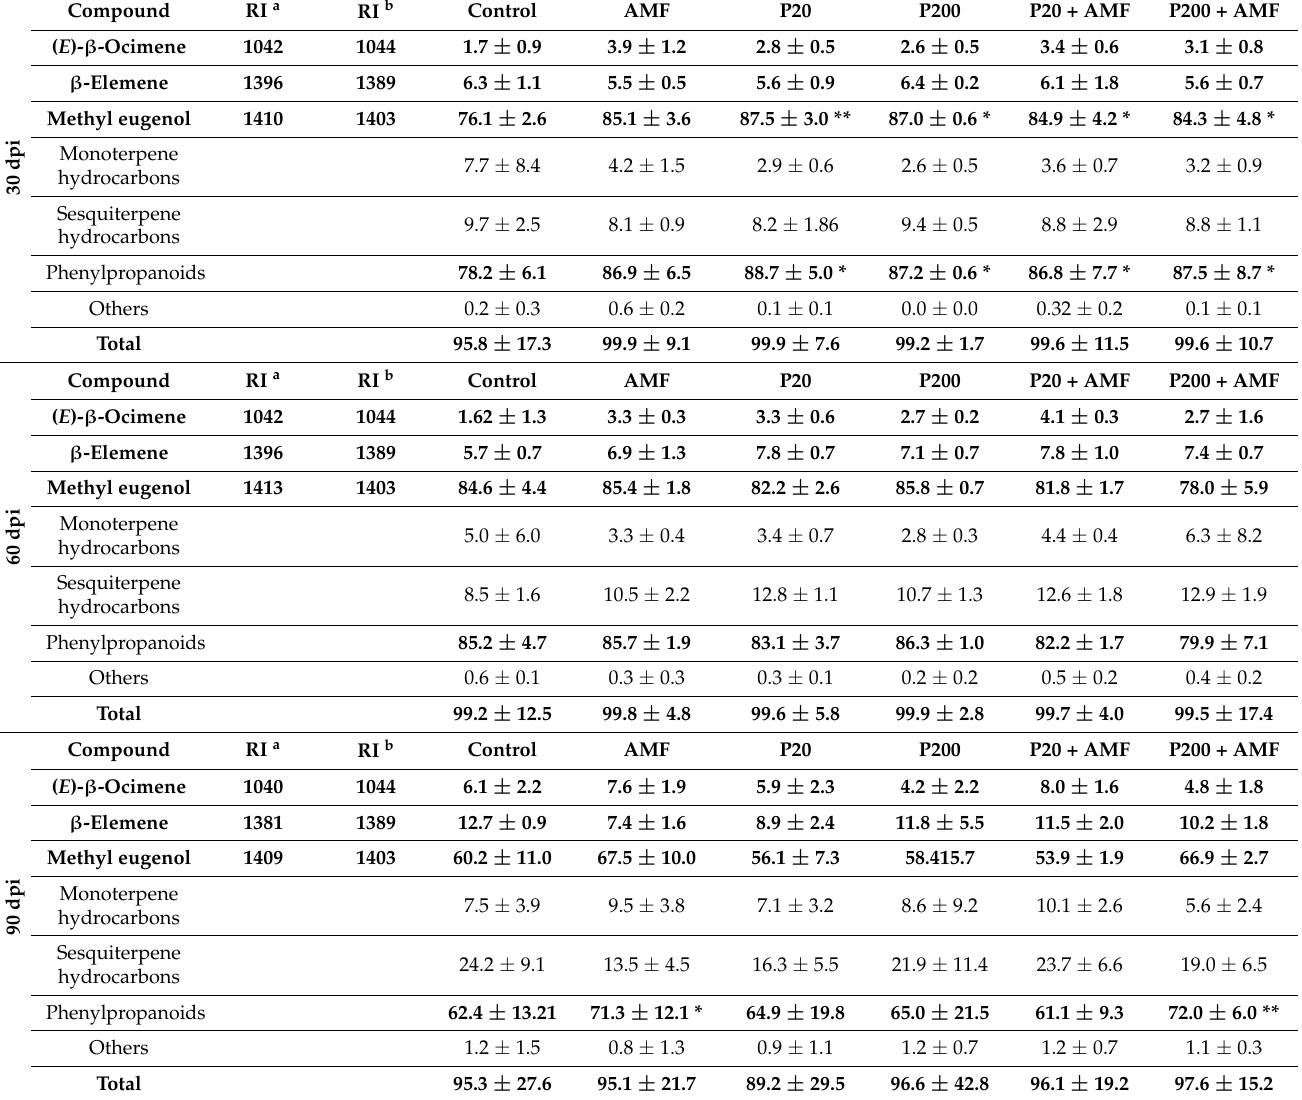
Table 4. Chemical composition of essential oil of Piper divaricatum leaves with addition of P and inoculated with AMF (means ± standard